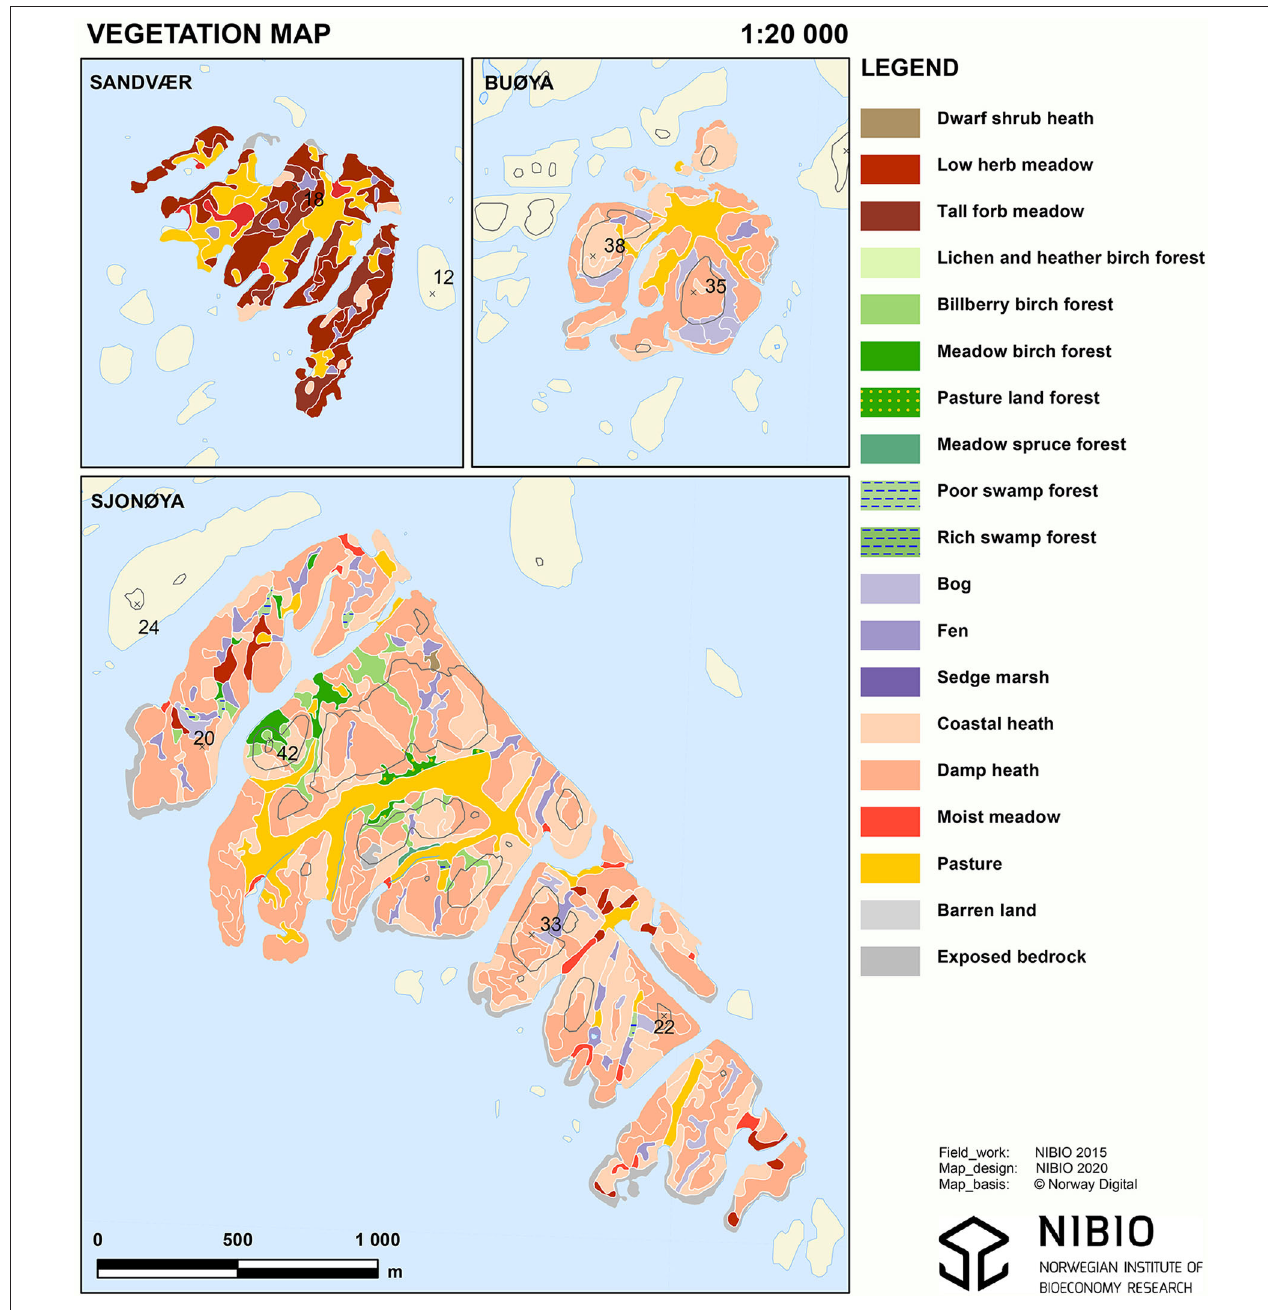
FIGURE 2 | Vegetation maps of Sandvær, Sjonøya, and